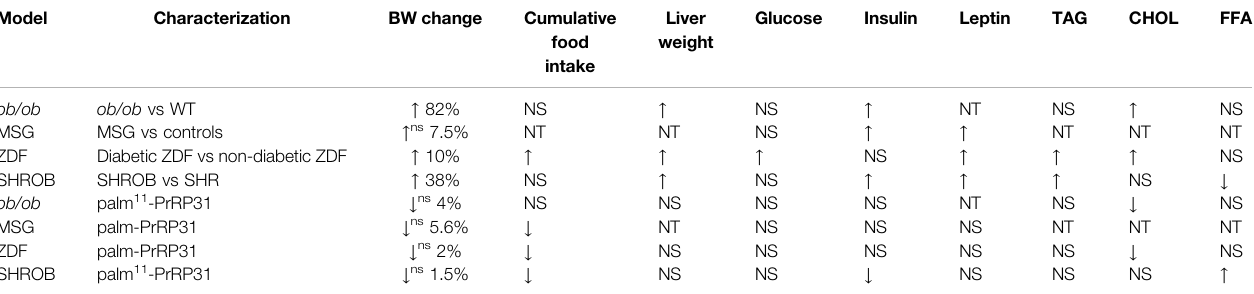
TABLE 3 | Summary of metabolic and morphometric parameters in rodent models of leptin de fi cient or leptin signaling disturbances and impact of treatment with palm- PrRP31 or palm 11 -PrRP31. Model